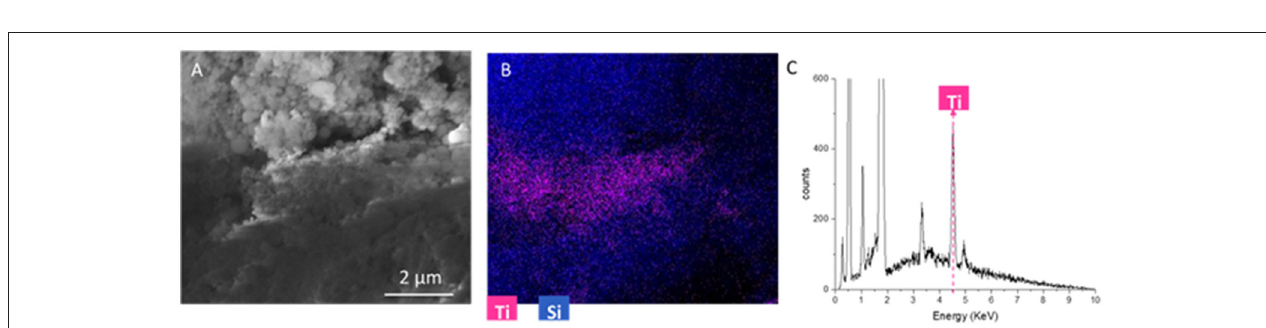
FIGURE 8 | (A) 30000X SEM image of the cross-section of the SUNSPACE sample, at a depth of 0.045mm from the surface (B) corresponding elemental composition map with color code. Titanium signal is represented by magenta (C) EDS spectrum of the volume with high Titanium content.